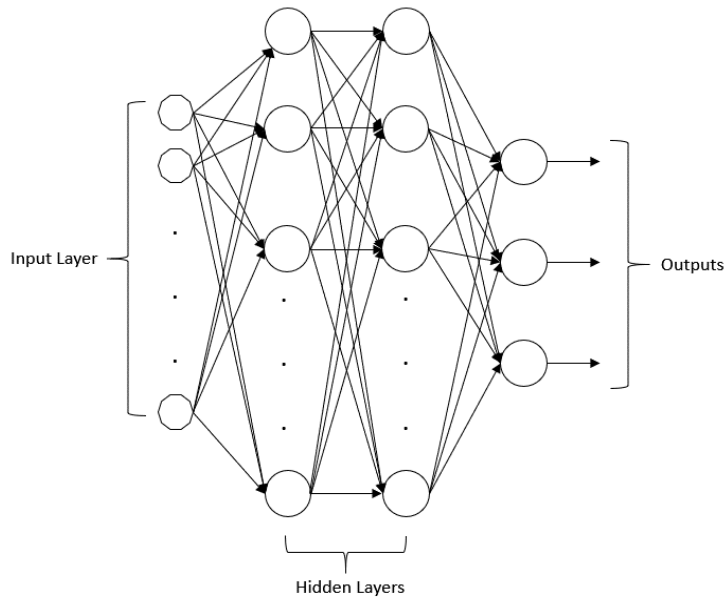
Figure 6. The structure of a fully connected automated neural network.